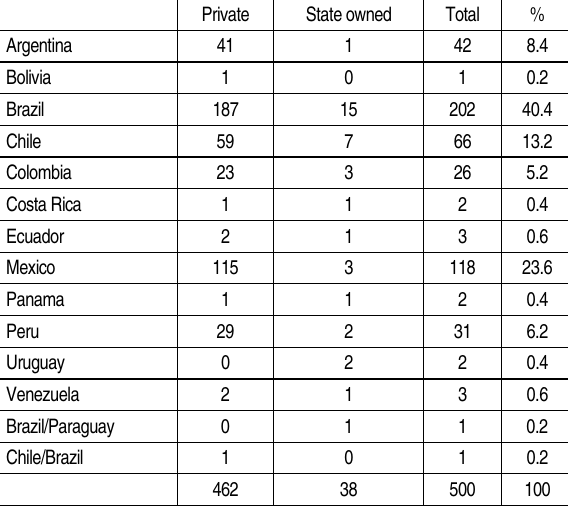
Table 1. Main characteristics of “The largest 500 companies in Latin America”